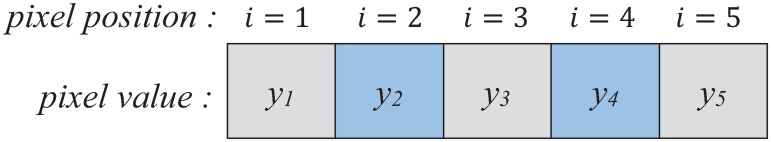
Pixel arrangement for a parabolic interpolation (PI).